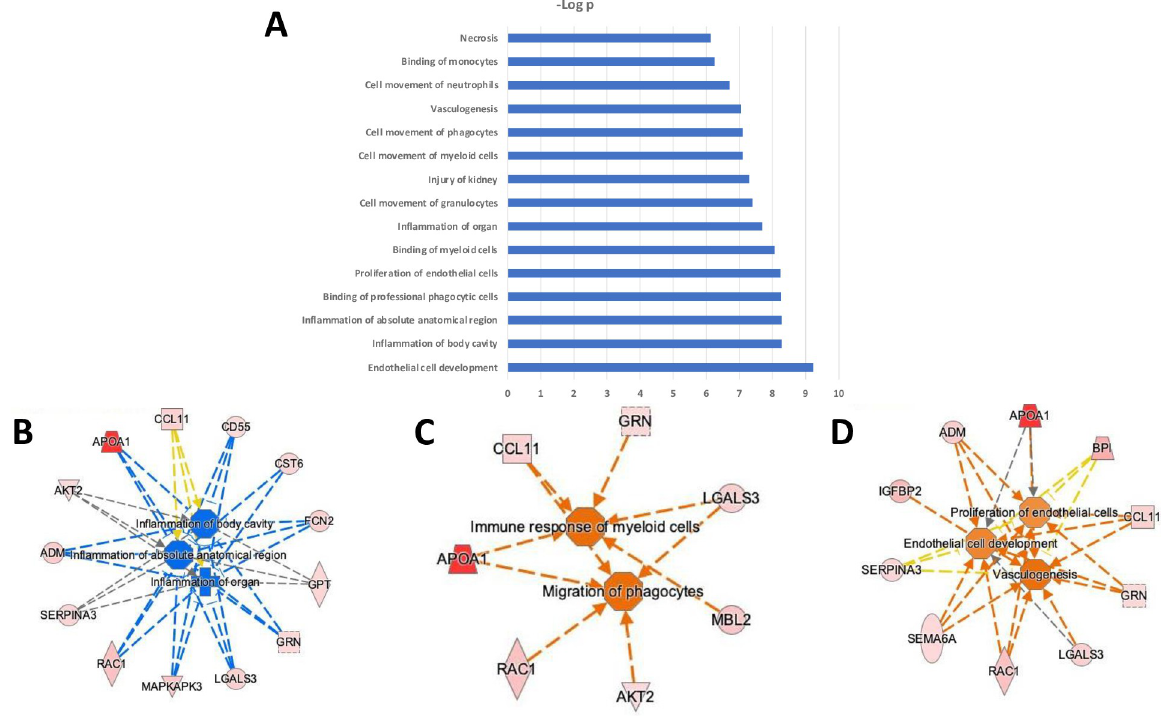
Fig 3. Upstream regulator analysis (A), downstream targets for TGF β (B), for TNF α (C), and for NFK β (D) of exosome proteins from patients with Raynaud’s Phenomenon with positive ANA compared to patients with Raynaud’s Phenomenon with negative ANA. IPA color and symbol guide: Blue = inhibition; orange = activation; red = increased; green = decreased; yellow = contrary to published evidence; grey = unknown; dashed line = indirect; arrowhead (pointed) = activating; arrowhead (blunt) = inhibitory. Proteins are coded by shape; square: Cytokine, vertical rhombus: Enzyme, horizontal rhombus: Peptidase, trapezoid: Transporter, ellipse: Transmembrane receptor, circle: Other.